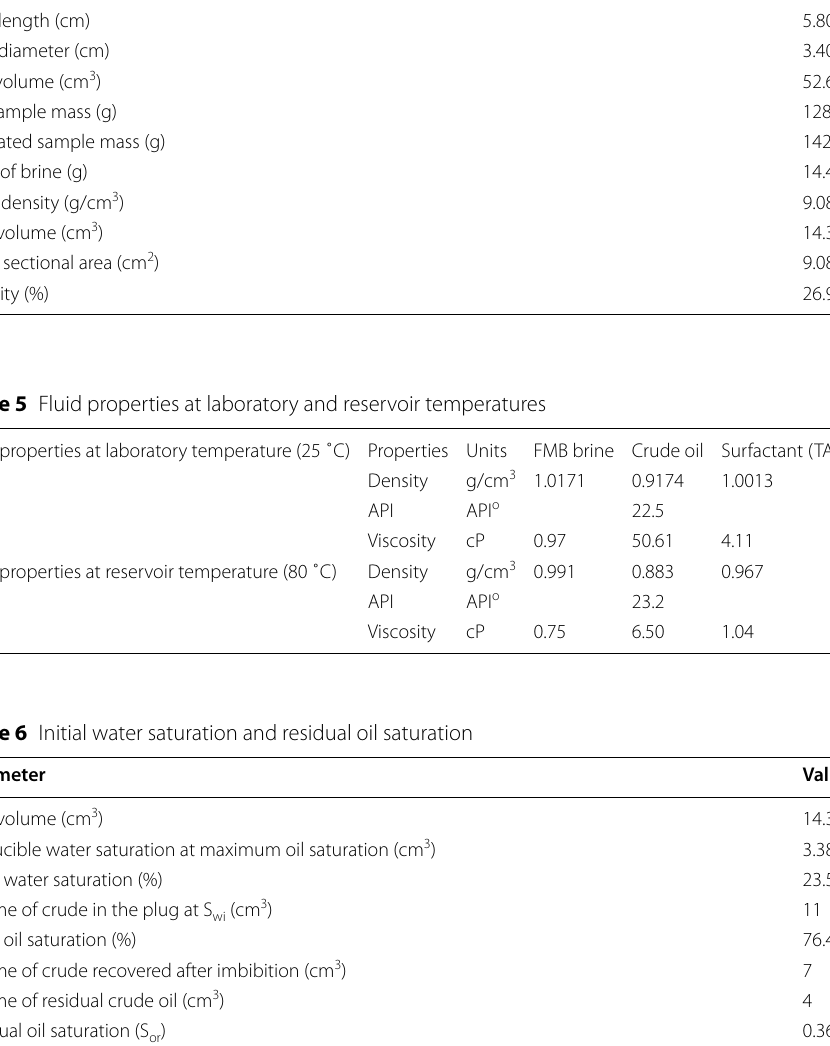
Table 4 Properties of sandstone core plug Parameter